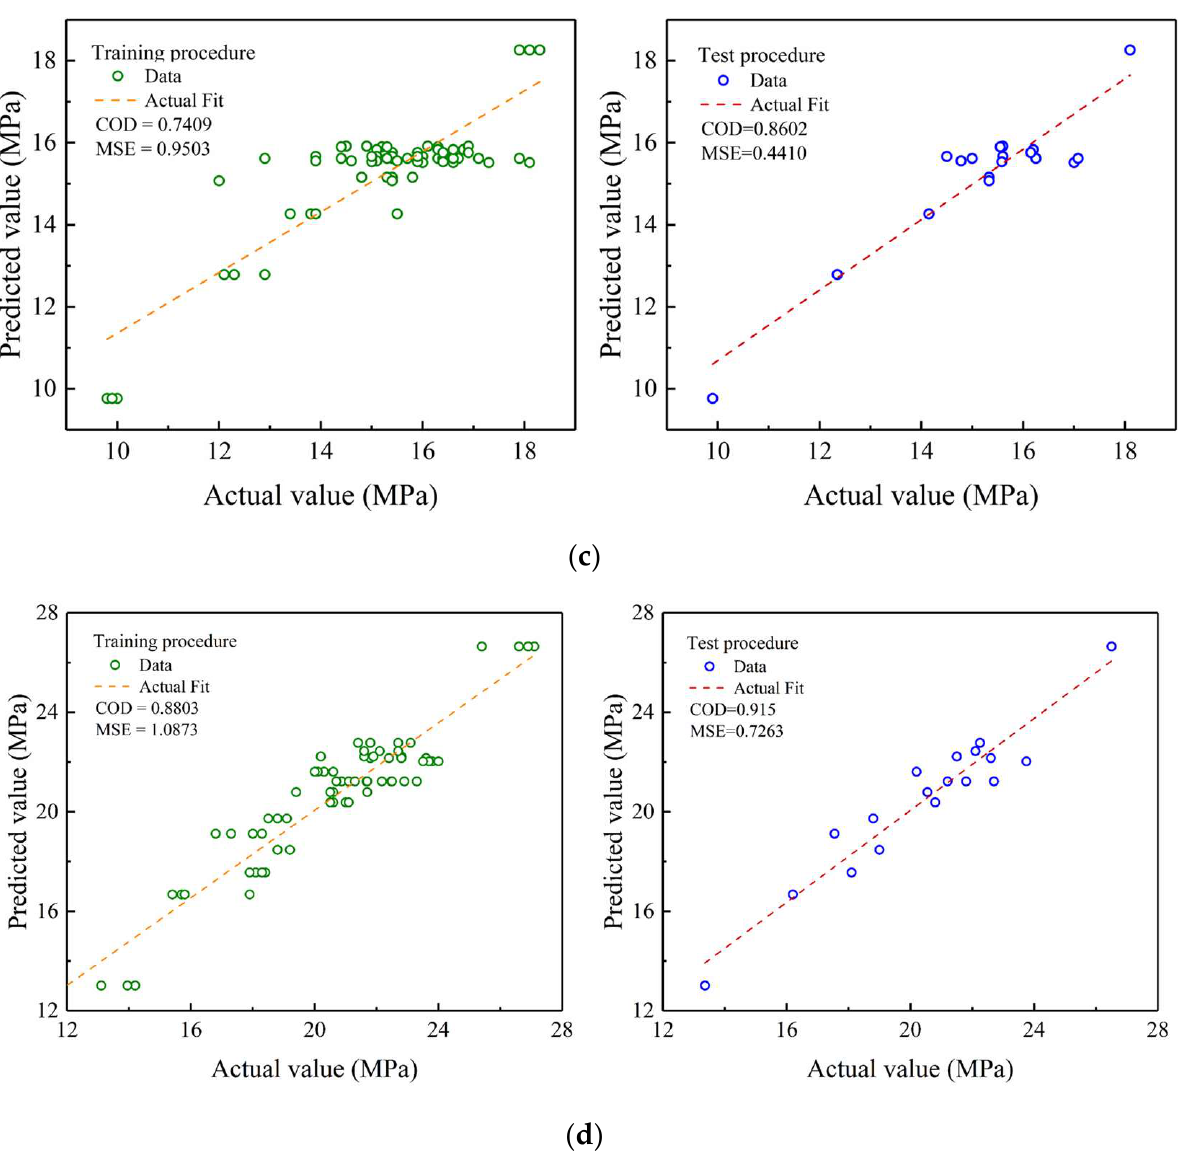
Figure 25. Predicted and actual value of compressive strength of each age. ( a ) Predicted value and actual value of compressive strength of 1d; ( b ) Predicted value and actual value compressive strength of 3d; ( c ) Predicted value and actual value of compressive strength of 7d; ( d ) Predicted value and actual value of compressive strength of 28d.